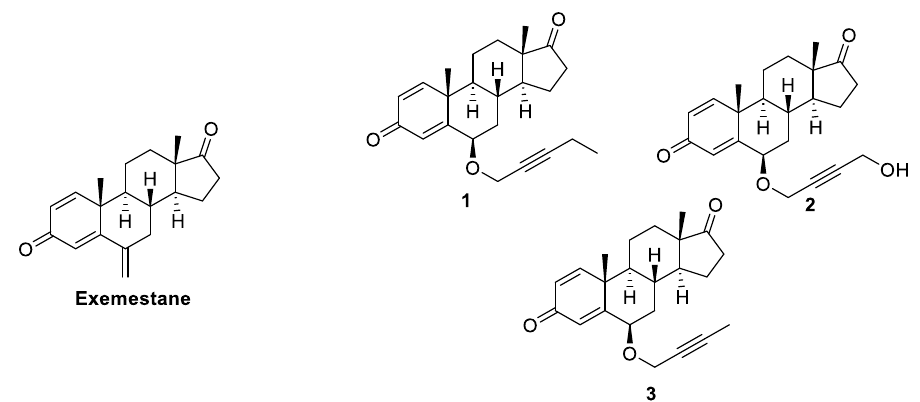
Figure 7. Steroidal HA inhibitors shown to occupy the active site access channel.